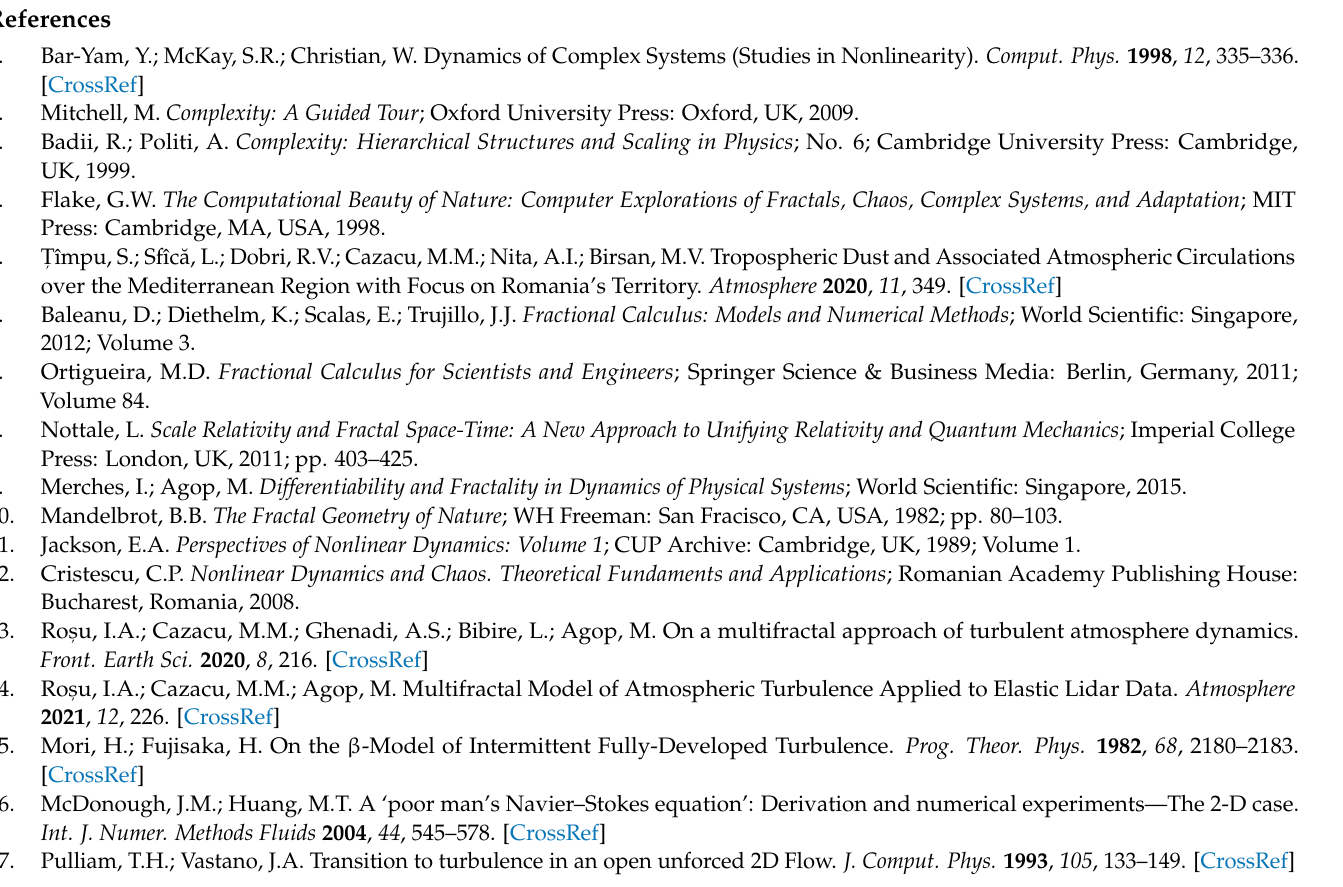
Figure A1. Comparison of n l pre-obtained with three initial parameters to C -approximated n l 0 parameters: ( a ) as a function of l 0 ; ( b ) as a function of l d